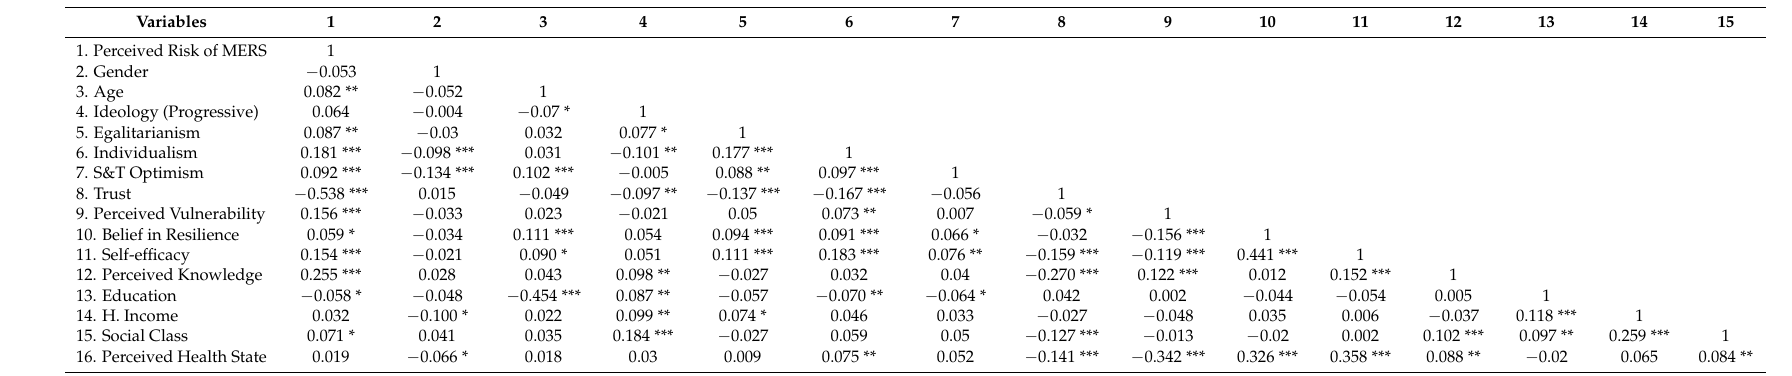
Table 3. Pearson’s correlation coefficients between perceived risk and other